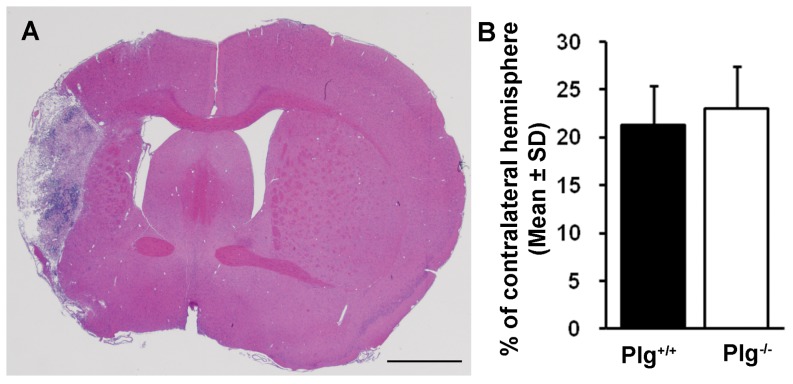
Ischemic lesion volume.A: A representative coronal section stained with hematoxylin and eosin shows ischemic infarct area. B: Quantitative data show there was no difference on the lesion volume between the Plg+/+ and Plg-/- mice at 28 days after stroke (n = 10/group). Scale bar = 1 mm.